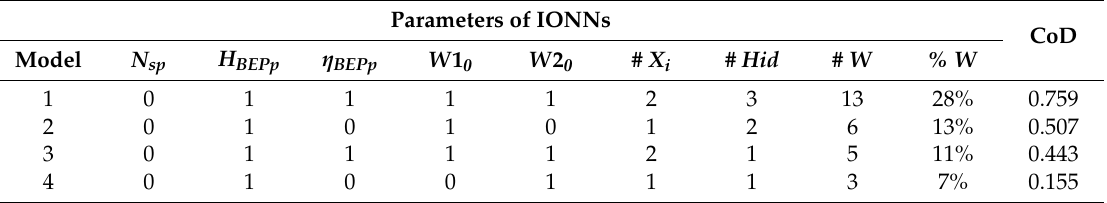
Table 6. Pareto front of IONNs for q for a hyperbolic tangent transfer function.